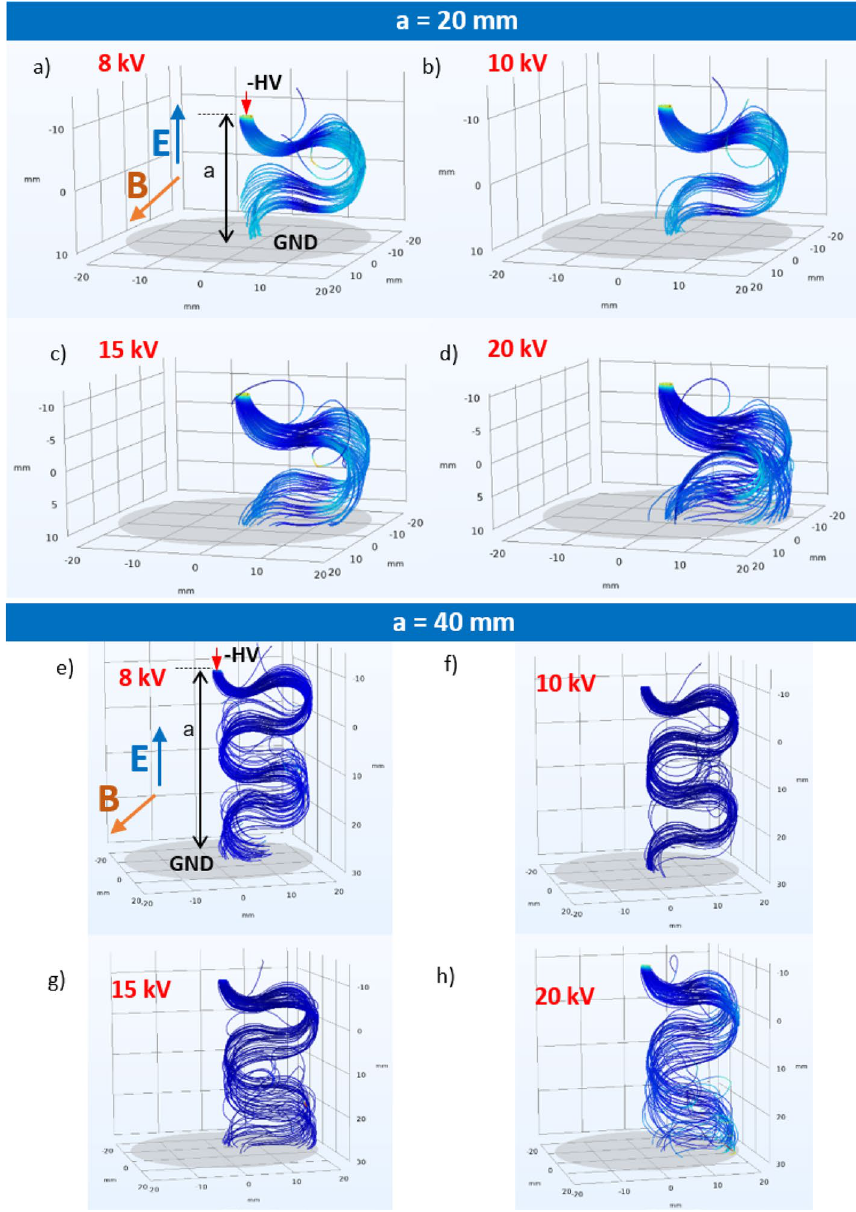
( c ) − 15 kV; ( d ) − 20 kV; ( e ) − 8 kV; ( f ) − 10 kV; ( g ) − 15 kV; ( h ) − 20